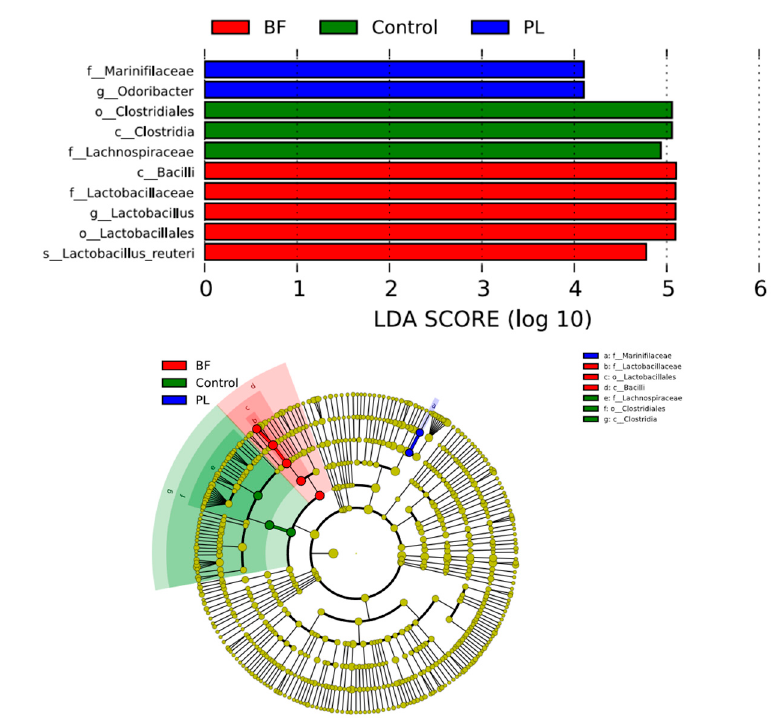
Figure 10. LDA scores ( A ) and Cladogram ( B ) of the fecal samples of bacterial communities. Note: PL means planktonic group; BF means biofilm group.